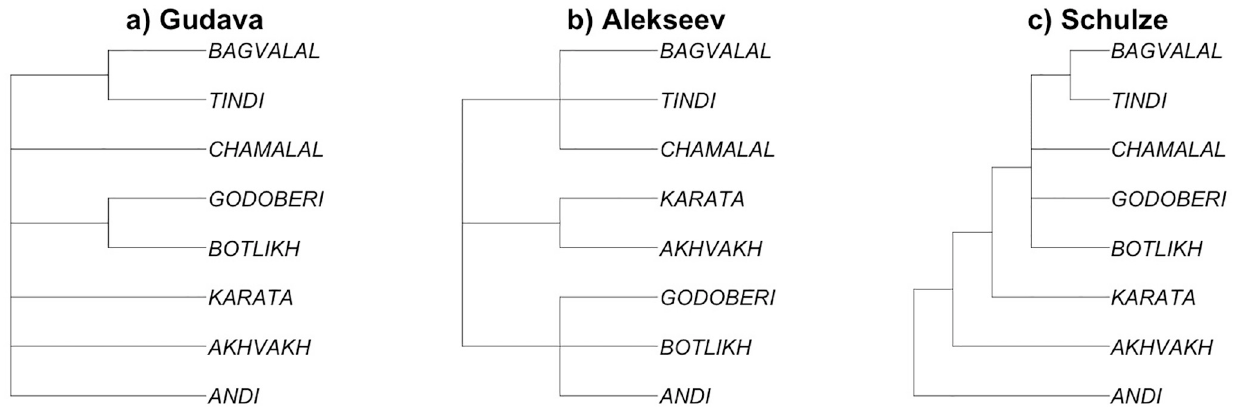
Fig 2. Qualitative approaches to the classifications of Andic languages. Tree tips represent languages, and branch lengths are all plotted equally.